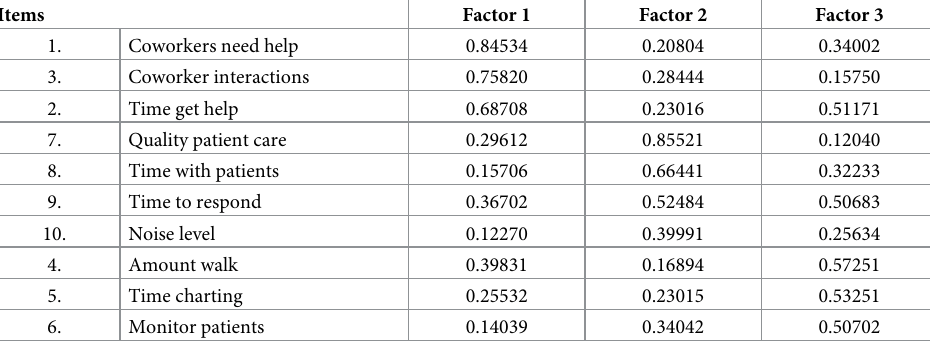
Table 7. Phase 1 varimax rotated three-factor model loadings.